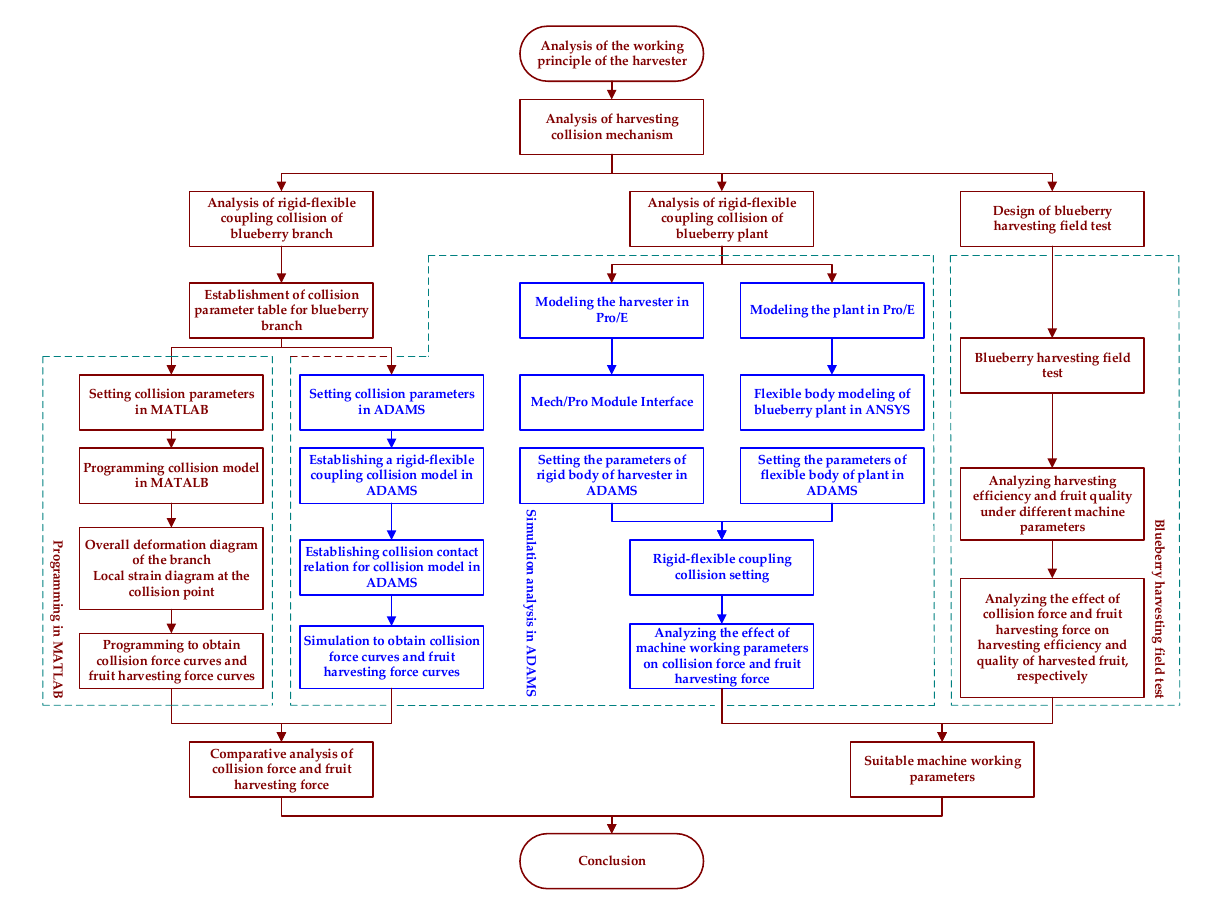
Figure 1. Flowchart of the research.